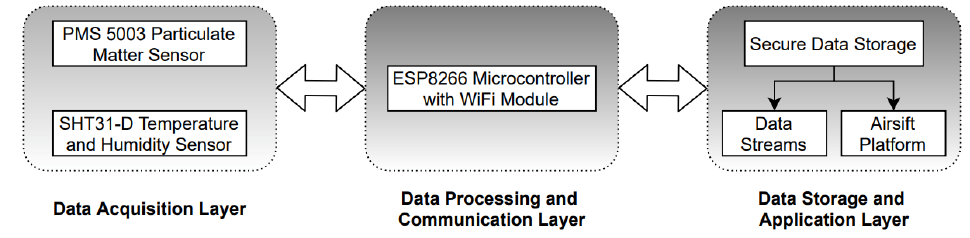
Figure 3. System